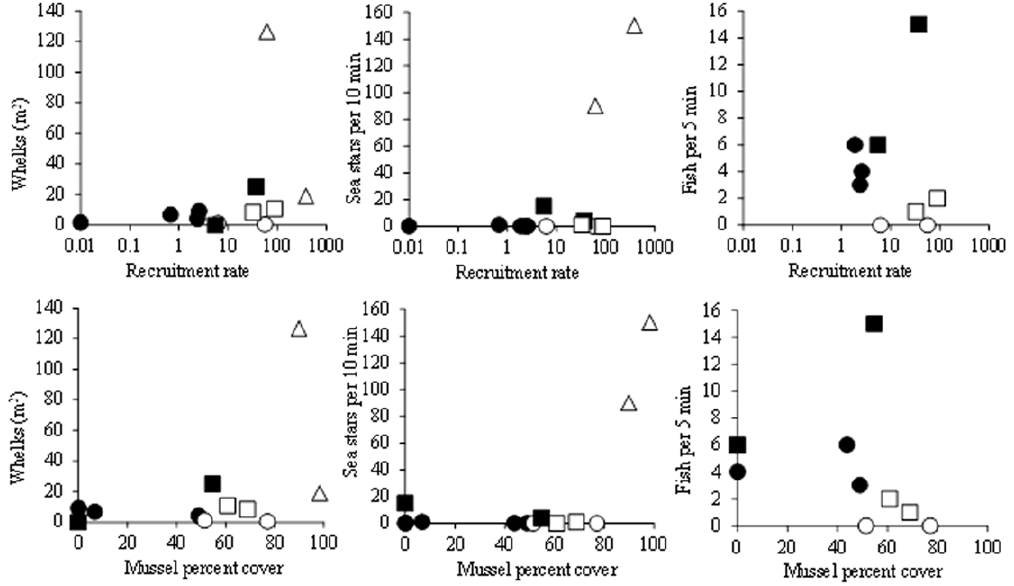
Figure 5. The relationships between mussel recruitment rates or mussel percent cover and predator abundance. Recruitment is per collector per day on a log scale and predator abundance is per m 2 for whelks and per search time for sea stars and fish. Symbol shapes and fills as in Fig. 4.